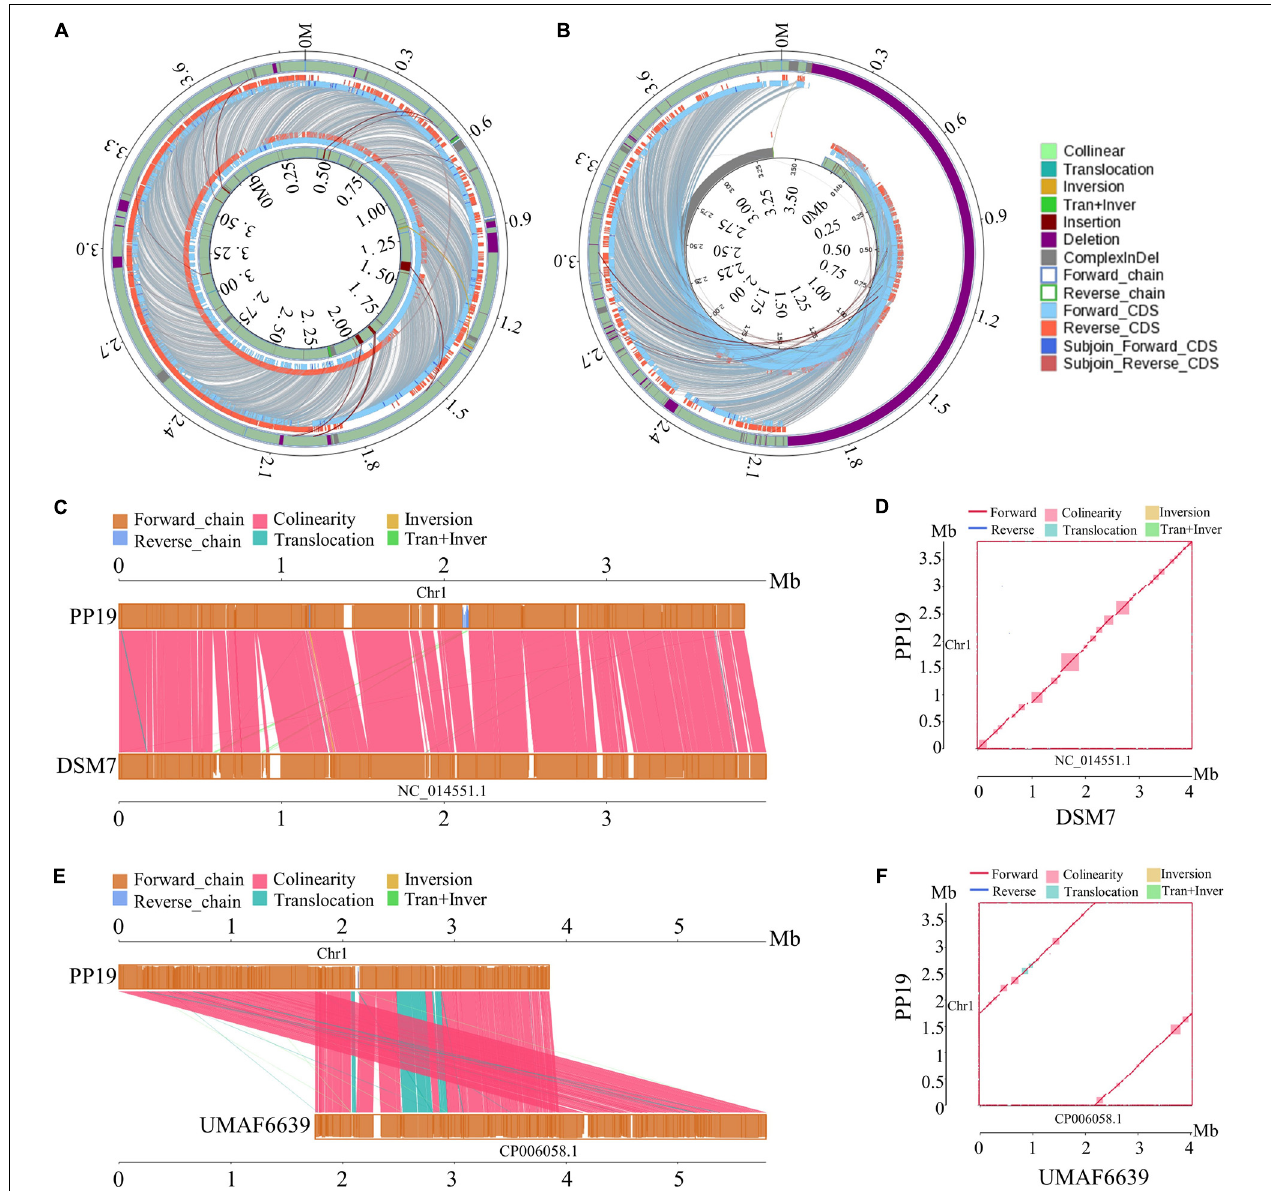
FIGURE 2 | Chromosome structural variation (SV) and synteny analysis between PP19 and DSM7, PP19 and UMAF6619. (A) SV analysis between PP19 and DSM7, (B) SV analysis between PP19 and UMAF6619, (C,E) synteny analysis between PP19 and DSM7, PP19 and UMAF6619 (parallel collinear graph), (D,F) synteny analysis between PP19 and DSM7, PP19 and UMAF6619 (two dimensional collinear graph). Collinear, collinear region; Translocation, translocation region; Inversion, inversion region; Tran + Inver, translocation and inversion region; Insertion, region where the inserted fragment is greater than or equal to 50 bp; Deletion, region where the deleted fragment is greater than or equal to 50 bp; ComplexInDel, region that is unmatched but located in the same region; Forward_chain, the forward chain of the genome sequence; Reverse_chain, the reverse chain of the genome sequence; Forward_CDS, CDS translating on the forward chain of genome sequence; Reverse_CDS, CDS translating on the reverse chain of genome sequence; Subjoin_Forward_CDS, supplementary CDS translating on the forward chain of genome sequence; Subjoin_Reverse_CDS, supplementary CDS translating on the reverse chain of genome sequence; when the matching sequence of the deleted gene or inserted gene reaches 100% consistency, the matching sequence is considered a supplementary